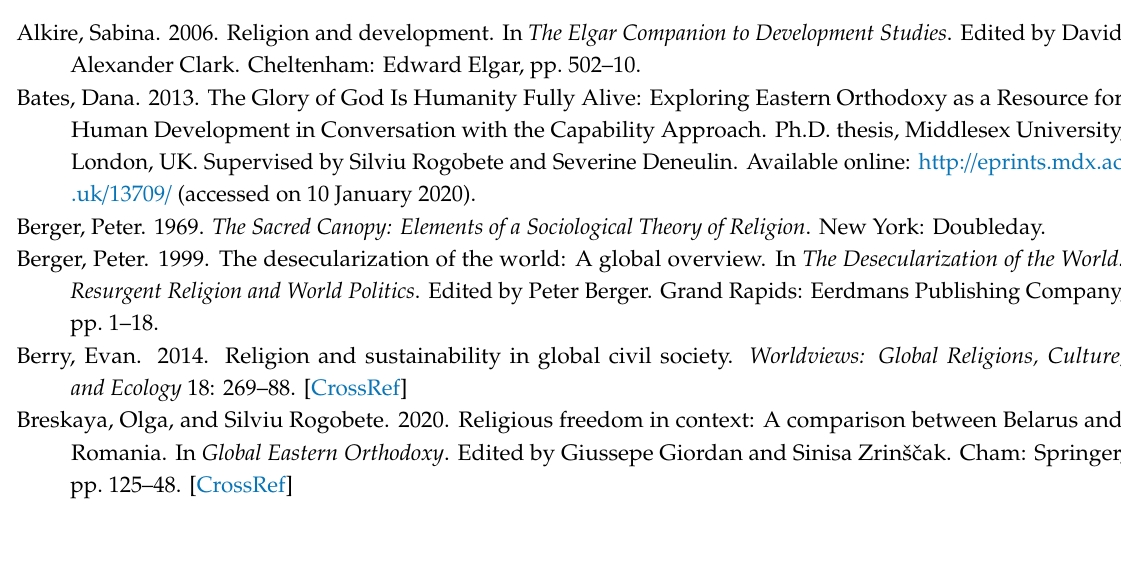
Table S2: Theism frequencies (%), means and standard deviation, Table S3: Religious belief frequencies (%), means and standard deviation, Table S4: Prayer frequencies (%), means and standard deviation, Table S5: Religious service attendance frequencies (%), means and standard deviation, Table S6: Individual value system frequencies (%), means and standard deviation, Table S7: Human dignity frequencies (%), means and standard deviation, Table S8: Civil rights frequencies (%), means and standard deviation, Table S9: Judicial rights frequencies (%), means and standard deviation, Table S10: Political rights frequencies (%), means and standard deviation, Table S11: Socioeconomic rights frequencies (%), means and standard deviation, Table S12: Religious a ffi liation frequencies (%), Table S13: Religious socialization frequencies (%), means and standard deviation, Table S14: Empathy frequencies (%), means and standard